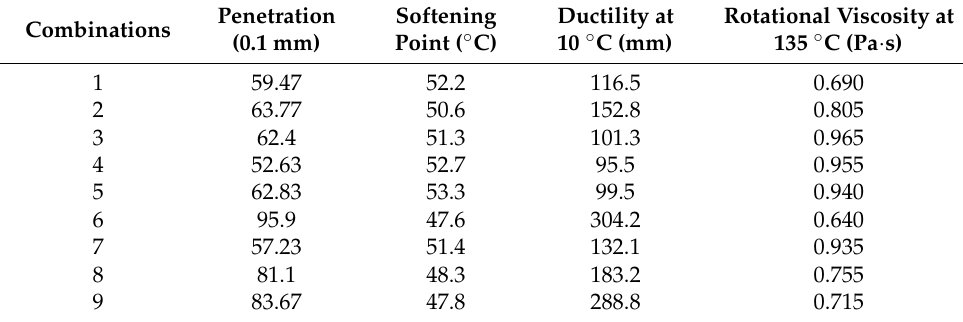
Table 7. Basic properties of orthogonal test.